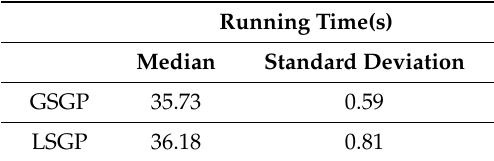
Table 2. Median and standard deviation of the running time (in seconds) for the two GP based